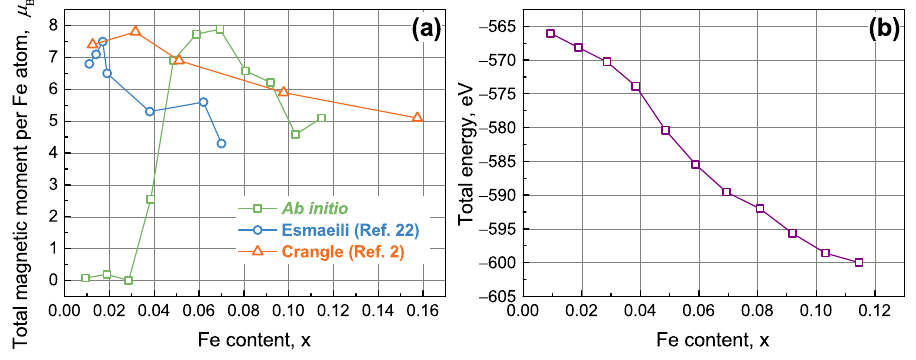
Figure 2. ( a ) Total magnetic moment calculated per Fe solute atom versus Fe content in the 3 × 3 × 3 Pd supercell (green line with squares), along with the experimental data plotted for MBE film (blue line with circles) and for the bulk (red line with triangles) taken from references [2,21], respectively; ( b ) Energy decrease with increase in the Fe atoms content x . Here, the total energy was calculated per 3 × 3 × 3 Pd supercell with uniform distribution of the Fe solute atoms.